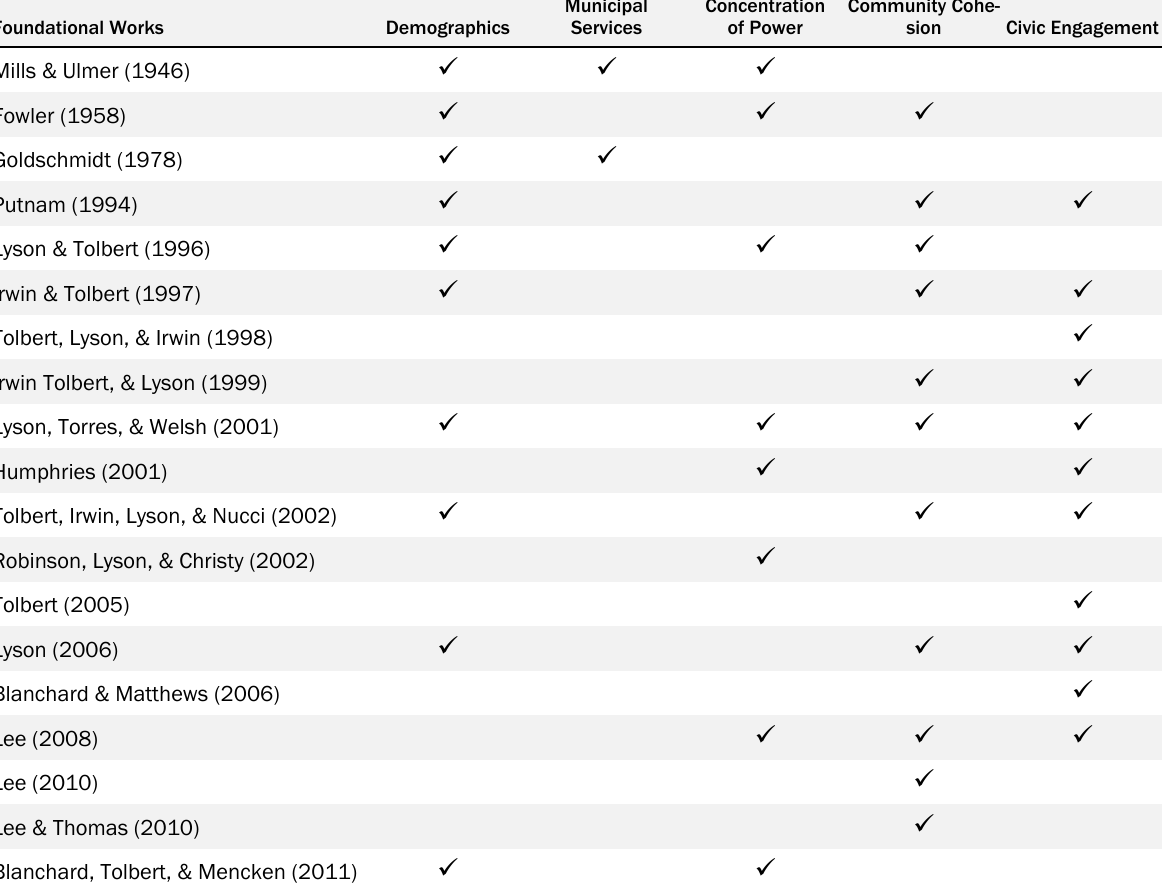
Table 2. Foundational Works in Civic Community Theory Examining Social Welfare Foundational